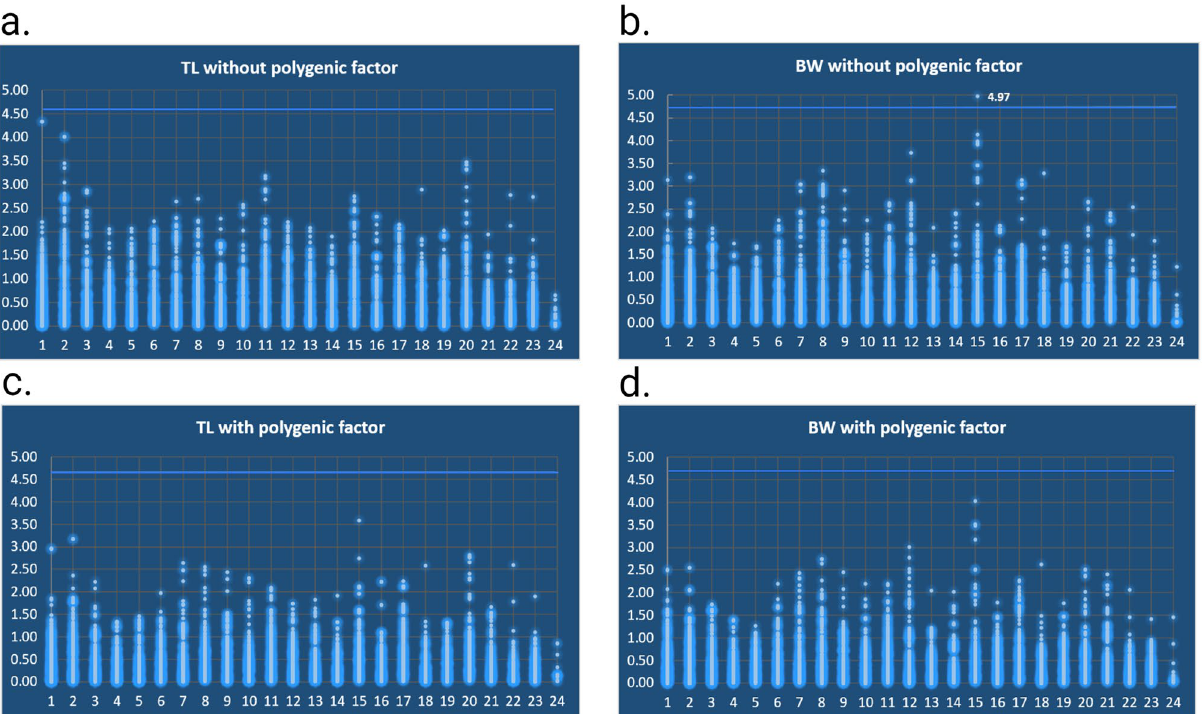
Figure 4. QTL scan results for the 2 models concerning BW (body weight) and TL (total length) traits. The x axis depicts the LGs from 1 to 24, and the y axis the LOD (logarithm of odds) scores that the markers attained for each model, trait and LG. The light blue lines are the threshold LOD values, which should be surpassed for a marker to be considered statistically